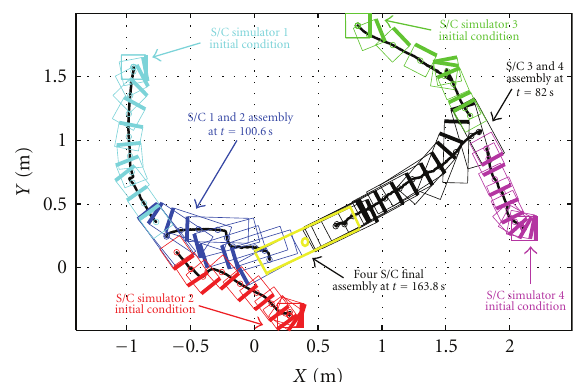
Figure 14: Experimental Result: bird’s eye view for four spacecraft simulator assembly maneuver. The relative navigation is performed via augmented state estimation. The bolded lines are employed to help visualize the simulator’s